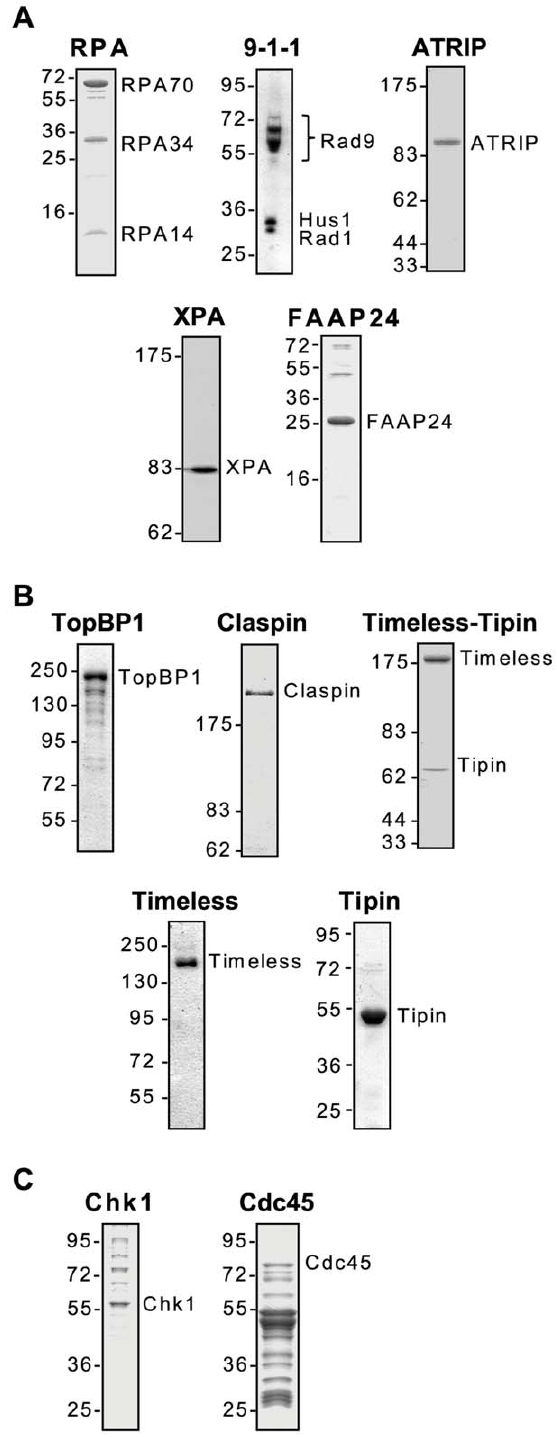
Figure 1. Purification of ATR-Chk1 pathway checkpoint proteins. Recombinant forms of the indicated checkpoint proteins were separated by SDS-PAGE and visualized by coomassie blue staining. Proteins are categorized into (A) DNA damage sensors, (B) mediators, and (C) transducers/effectors.